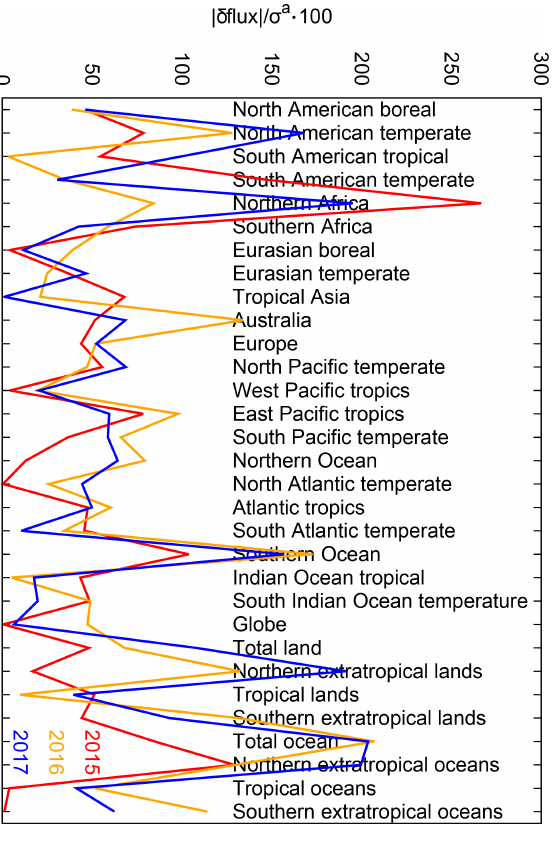
Figure 5. Ratio of the absolute difference ( δ flux) between the OCO-2-based annual fluxes and the surface-based annual fluxes to the Bayesian posterior flux uncertainty for the surface-based fluxes ( σ a ), in percent, for the years 2015, 2016 and 2017. Both inversions correspond to